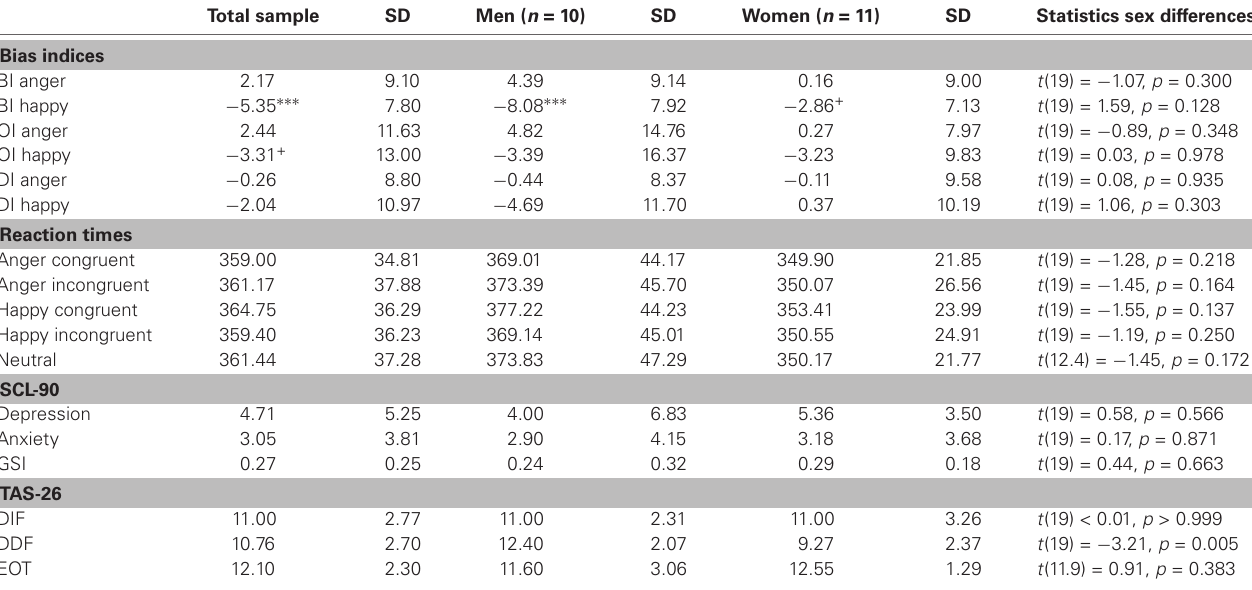
Table 1 | Means and standard deviations of bias index scores, reaction times, and psychological